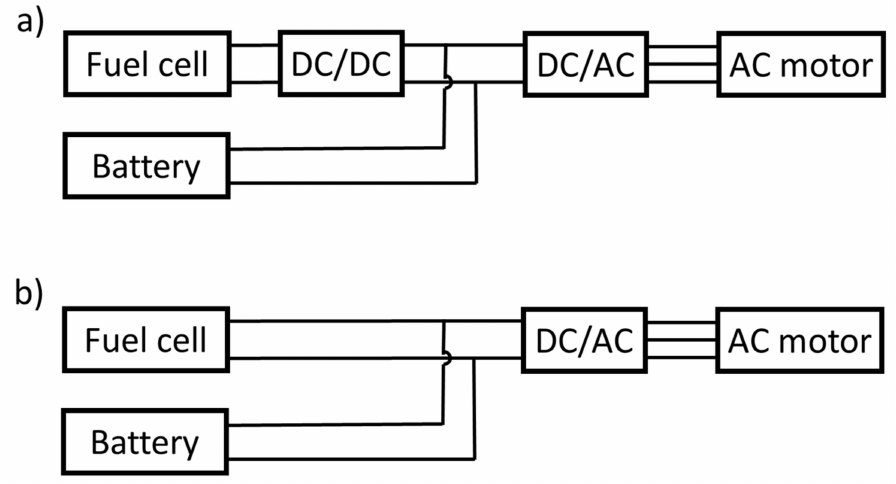
Figure 1. Active ( a ) and passive ( b ) fuel cell battery topology in conventional hybrid